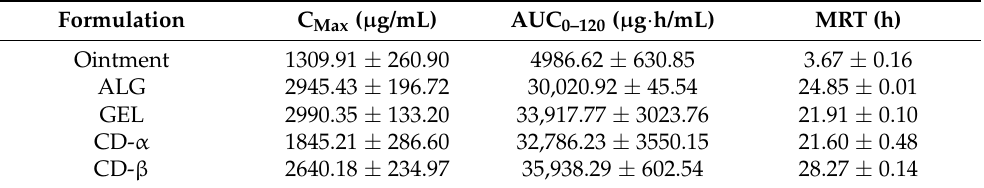
Table 6. The pharmacokinetic parameters of ERY-loaded ocular inserts tested in the rabbits’ eyes ( n =